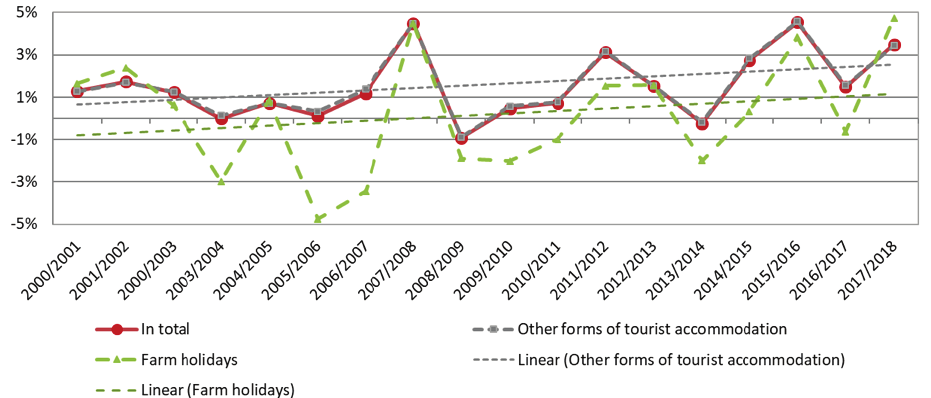
Figure 2: Overnight stays – year-on-year change rates in % from 2000/2001 to 2017/2018 (Statistics Austria 2019b)